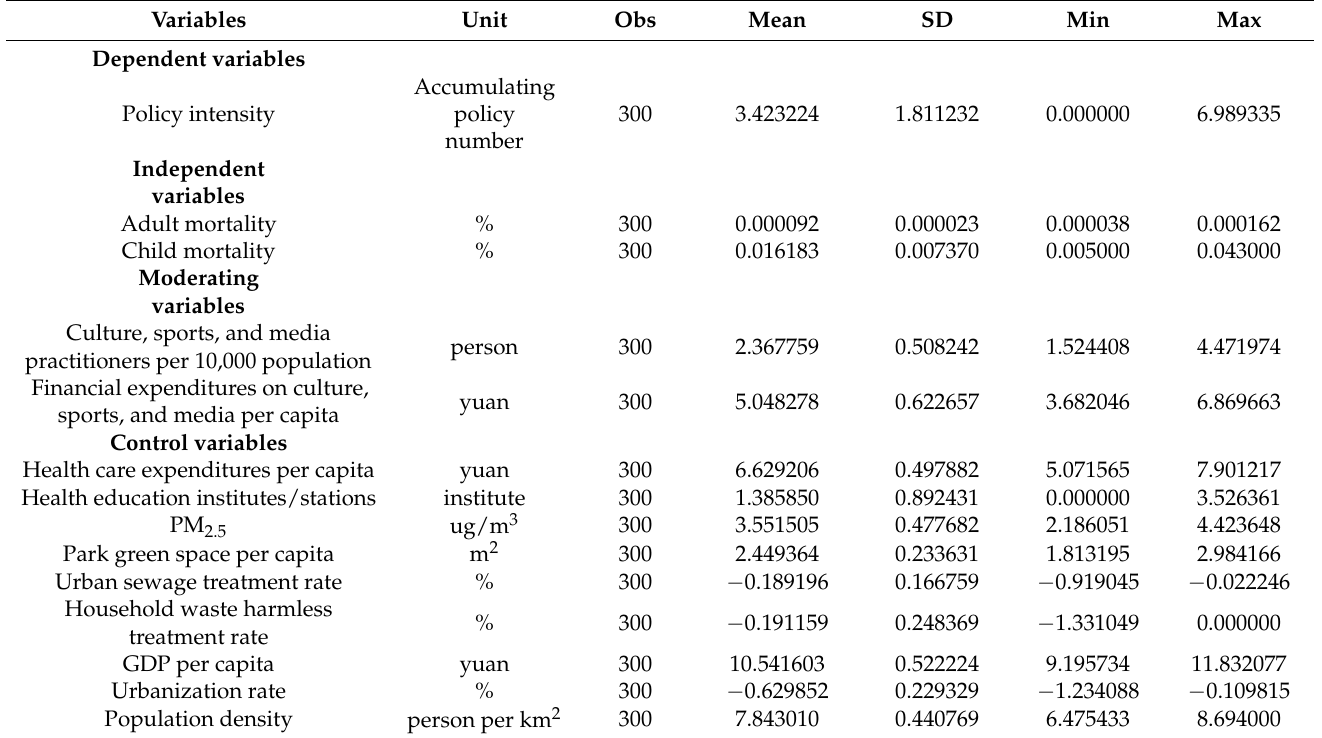
Table 1. Descriptive